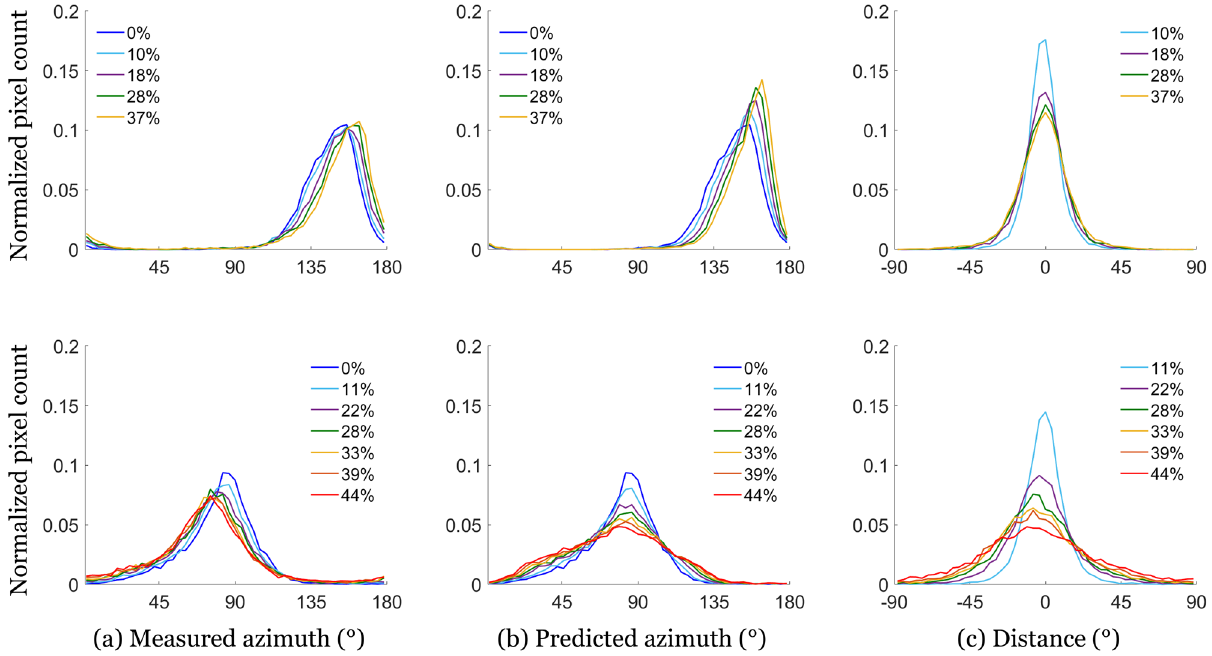
Figure 6. ( a ) Measured azimuth, ( b ) predicted azimuth, and ( c ) angular difference between measured and predicted azimuth distributions for sample 1 ( � α � ≈ 150 ◦ —top) and sample 8 ( � α � ≈ 80 ◦ —bottom), at different stretch levels. The predicted distributions are obtained using the affine